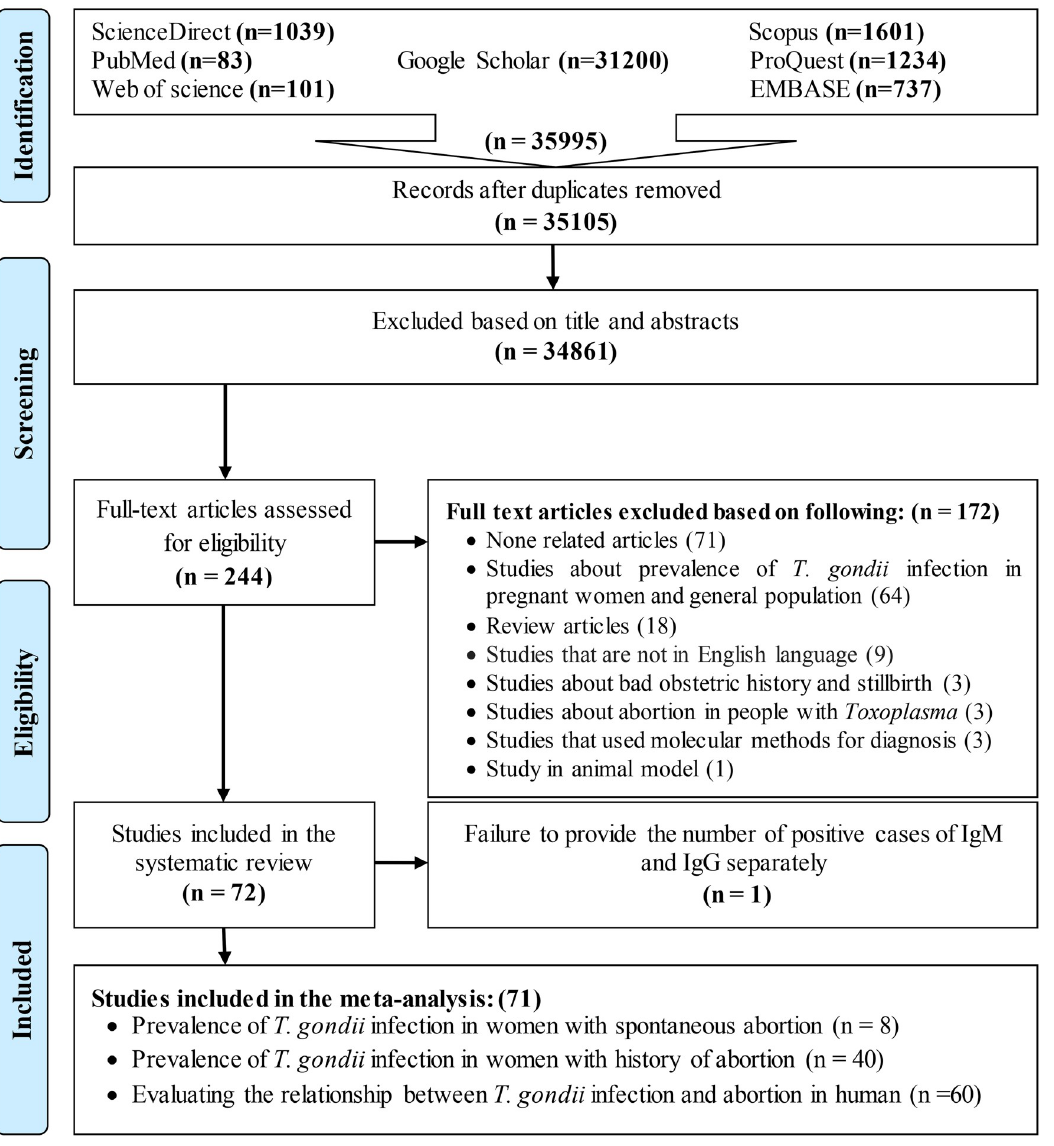
Fig 1. Flow diagram of the study design